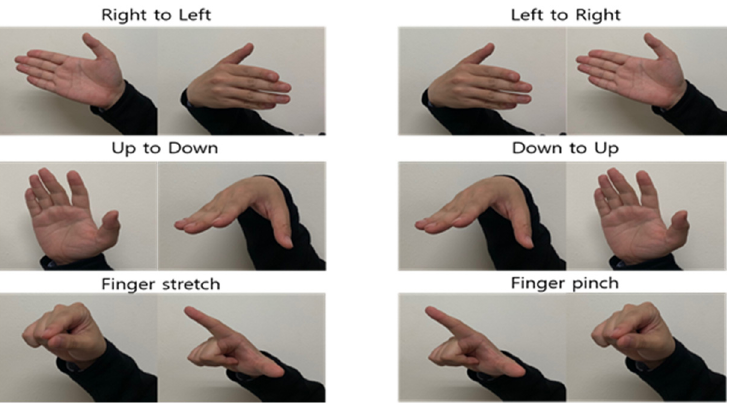
Figure 5. Types of hand gestures.